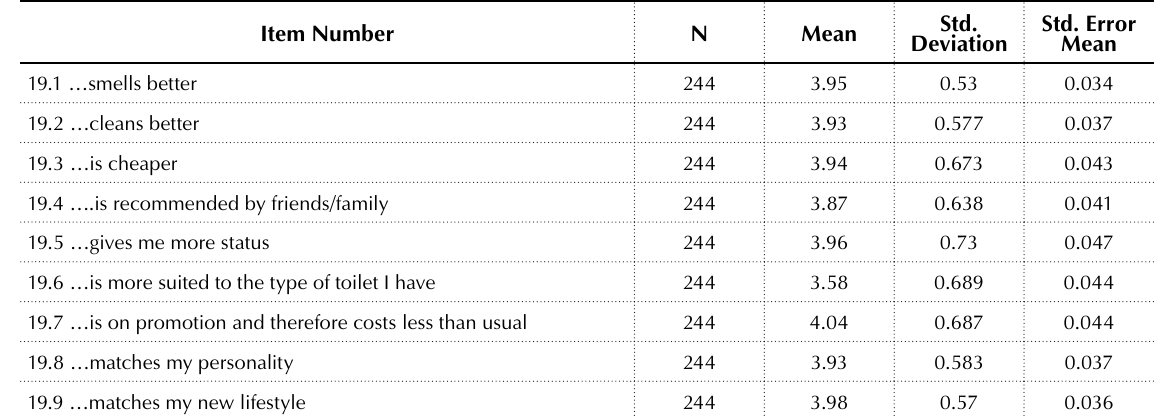
Table 6. Reasons for switching